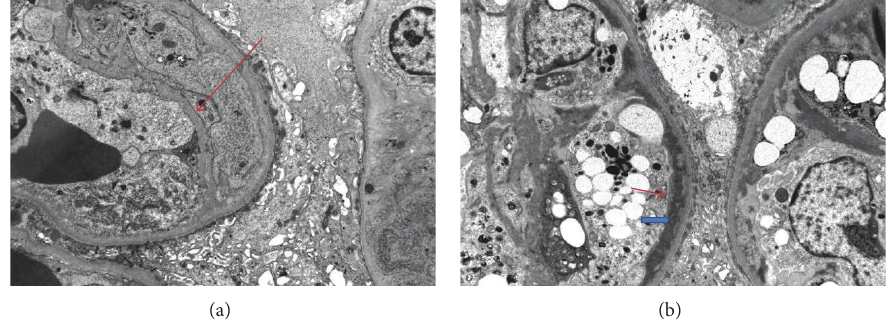
Figure 6: Electron micrograph of a glomerulus showing duplication of the GBM ((a) red arrow). Small subendothelial electron dense deposits ((b) blue arrow), underlaid by a thin layer of duplicated GBM ((b) red arrow), are also present (electron